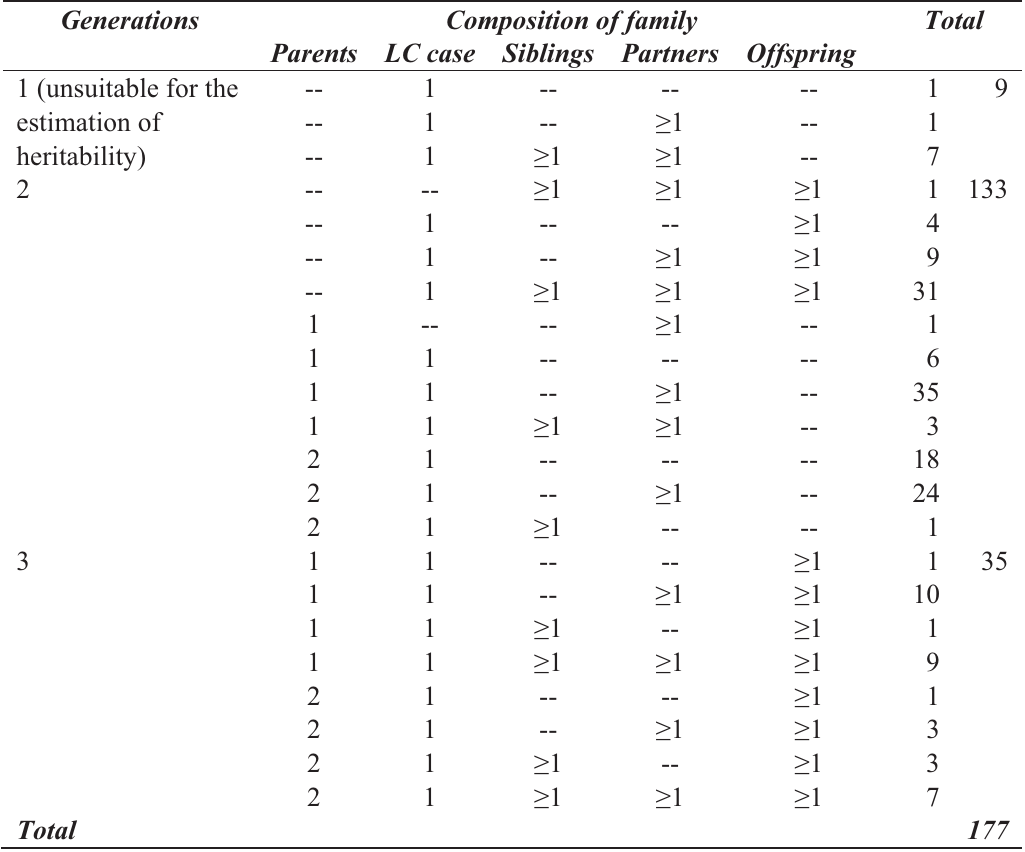
Table 1. Types of families in the study